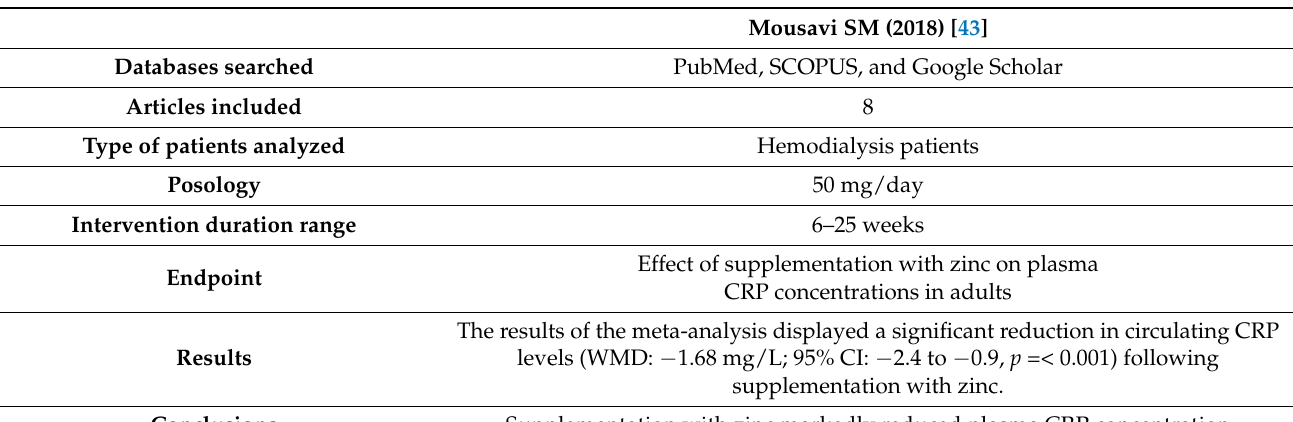
Table 7. Zinc: characteristics of the included systematic reviews.